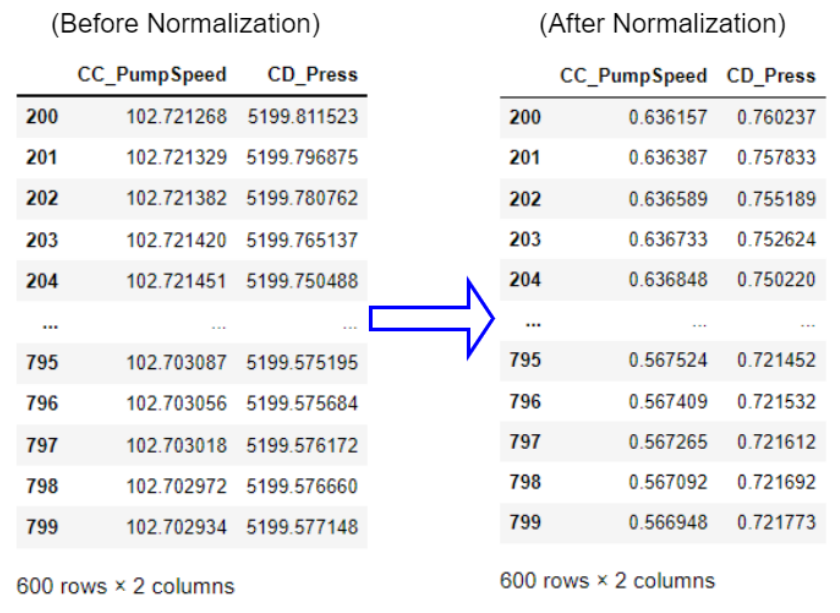
Figure 33. CC_PumpSpeed and CD_Press—data